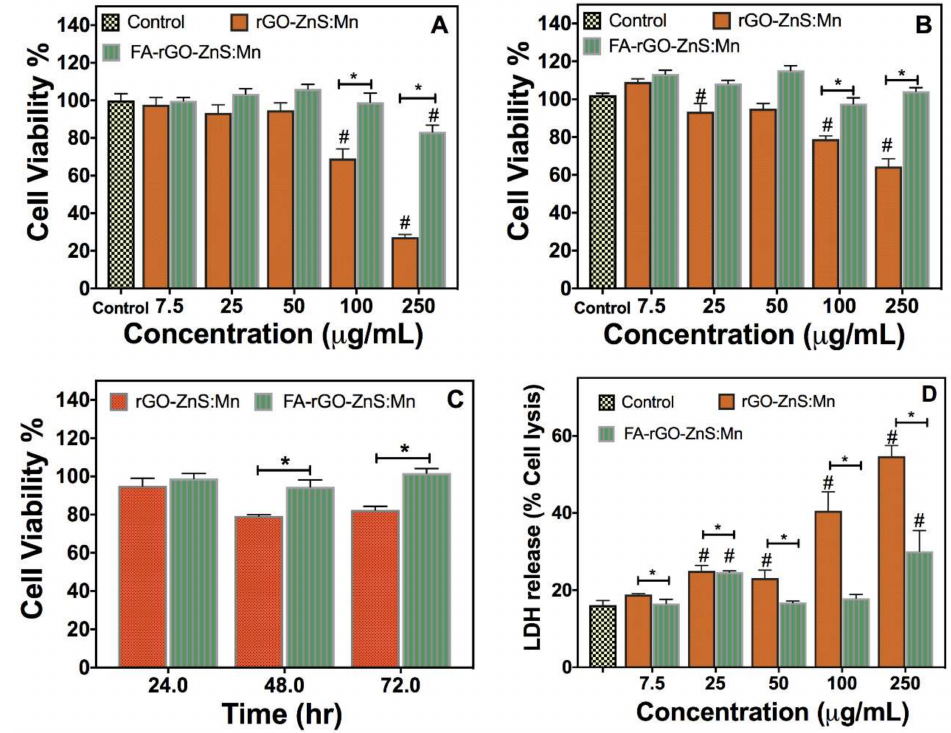
Figure 5. In-vitro MTS cytotoxicity assays showing the ( A ) MDA-MB 231 and ( B ) NIH-3T3 cell viability when exposed to FA-rGO/ZnS:Mn and rGO/ZnS:Mn after 24 h of incubation; ( C ) The incubation time dependence on MDA-MB 231 cell viability after an exposure dose of 50 µ g/mL for FA-rGO/ZnS:Mn and rGO/ZnS:Mn; ( D ) LDH release of MDA-MB 231 cells at different exposure doses of FA-rGO/ZnS:Mn and rGO/ZnS:Mn for 24 h. ( D ) Data are presented as the mean ± standard deviation (SD; n = 3). p value < 0.05 was chosen as the significance level, p values indicated with (#) correspond to p < 0.05 vs. control, and (*) for p < 0.05 between two different